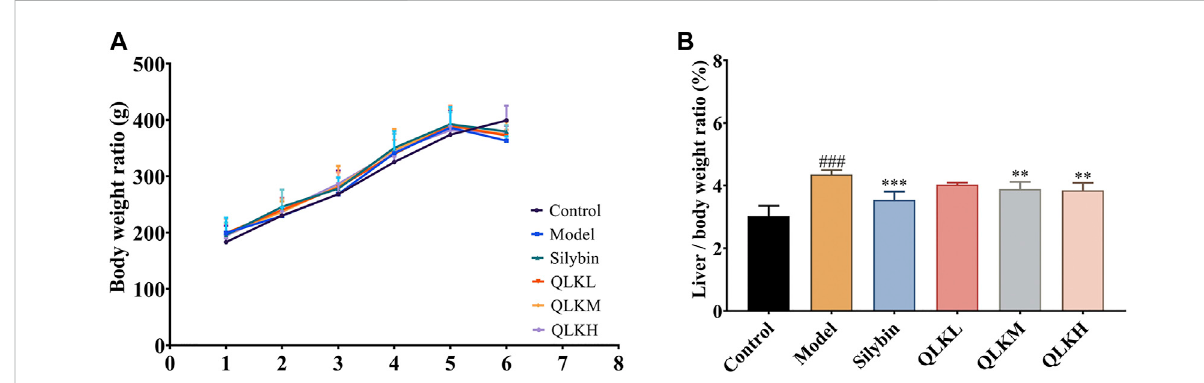
FIGURE 4 Effect of QLK treatment on the body weight and liver index in the CCl 4 rats ( n = 6). (A) Body weight for 6 weeks (B) Liver index. Values are presented as mean ± SD for three biological replicates per group. ** p < 0.01 vs. model, *** p < 0.005 vs. model, ### indicates p < 0.001 vs. control. QLK, quercetin-luteolin-kaempferol.